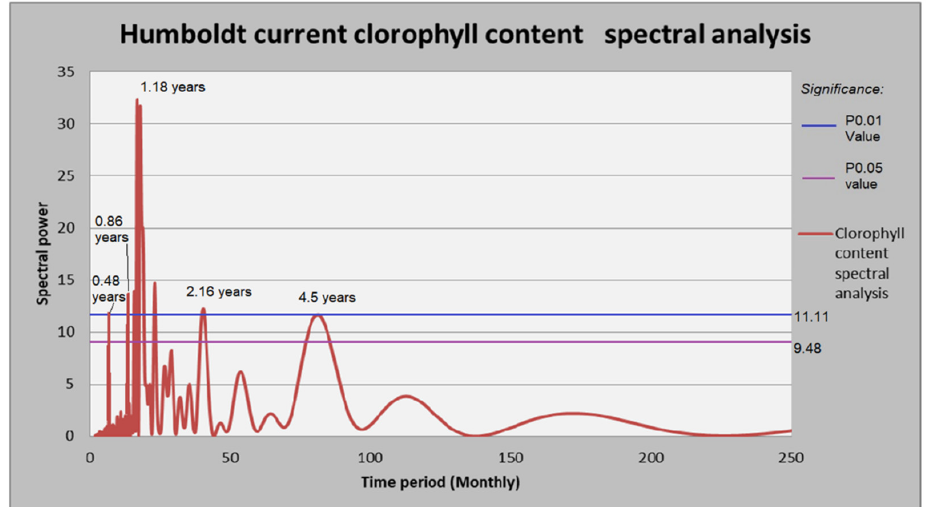
Figure 5. Spectral analysis of the chlorophyll content of the Humboldt Current (intensity) for the period 1997–2017 on a monthly scale. The red line represents the variability of the spectral power, while the blue line represents the minimum value of significance P0.01 (11.11) and the purple line represents the minimum value of P0.05 (9.48).